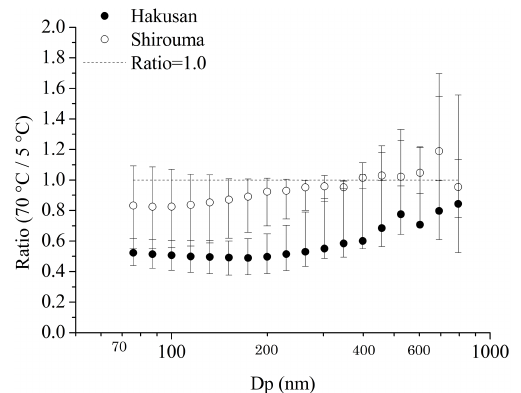
Figure 3. Size distribution of the ratio of the BC mass concentration in the snow samples melted at 70 ◦ C to those at 5 ◦ C.